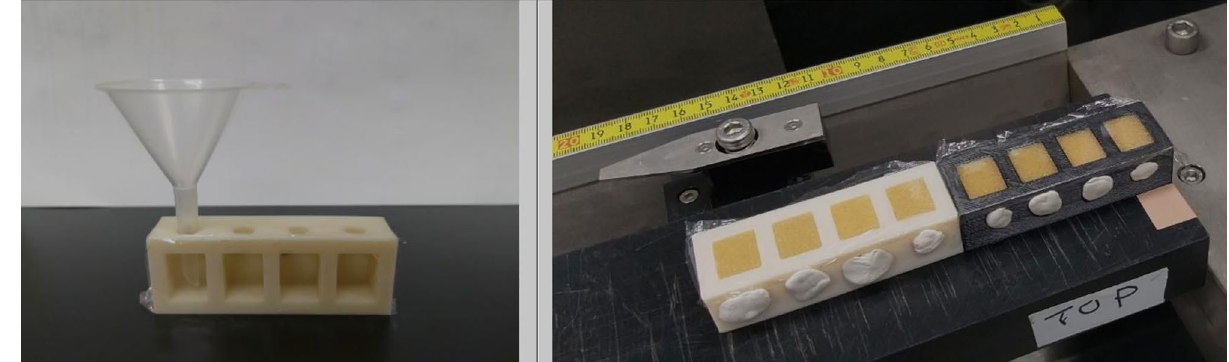
Figure 1. Sample carrier for granular or powdered samples. ( A ) The compartment openings are covered with XRF film and then the carrier is flipped 90 degrees, filled with resin, sealed, flipped back, and then mounted onto the rails of the Itrax XRF Core Scanner. ( B ) The whole carrier is scanned in one procedure, but only spectra from the middle of each compartment are used to avoid edge effects and bias from the carrier